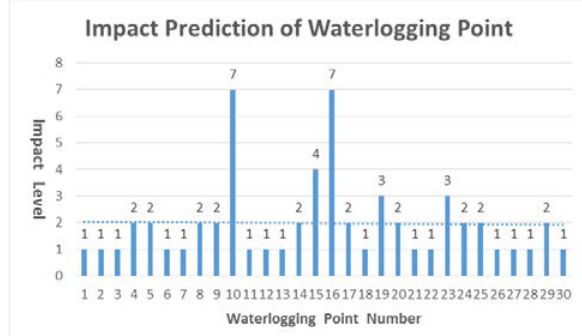
Fig.7. Influence degree prediction map of waterlogging points From the results of model prediction, the influence degree of waterlogging points are generally distributed in the first and second level, as shown in dotted line. The individual prediction value of waterlogging influence is far more than other waterlogging points, such as No. 10 (Wenxiu Street Wenxiang Road to Wenxin Street two-way), No. 16 (Huang Lu Road, Ming Road junction), whose waterlogging influence degree are 7. The part of waterlogging points’ prediction values are slightly higher than the others’, such as No. 15 (Second Ring Road, Liyuan Hospital entrance), No. 19 (Stomatological Hospital entrance) and No. 23 (Southland Installed Gate entrance), whose influence degree are between 3 to